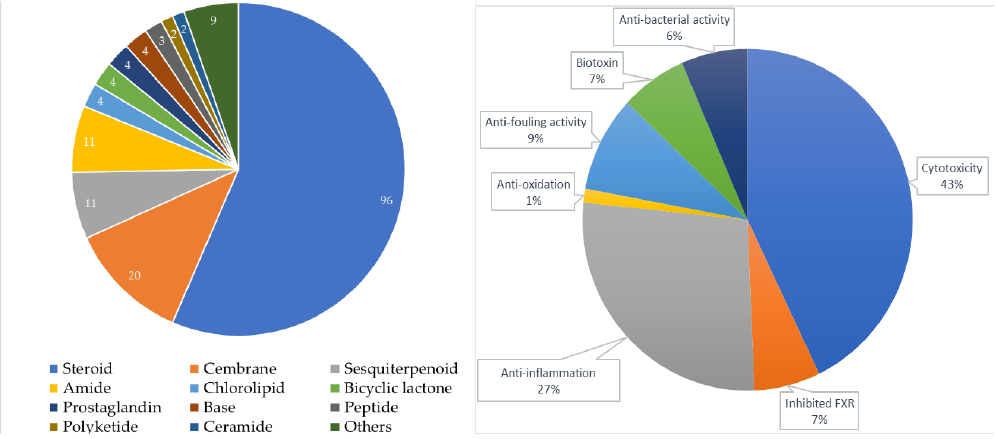
Figure 28. Biomedical activities of natural products from Dendronephthya spp.